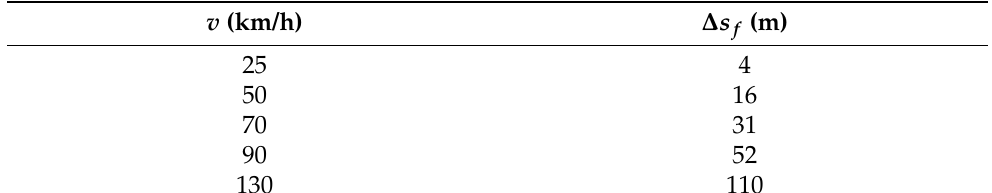
Table 4. Speed and braking distance.